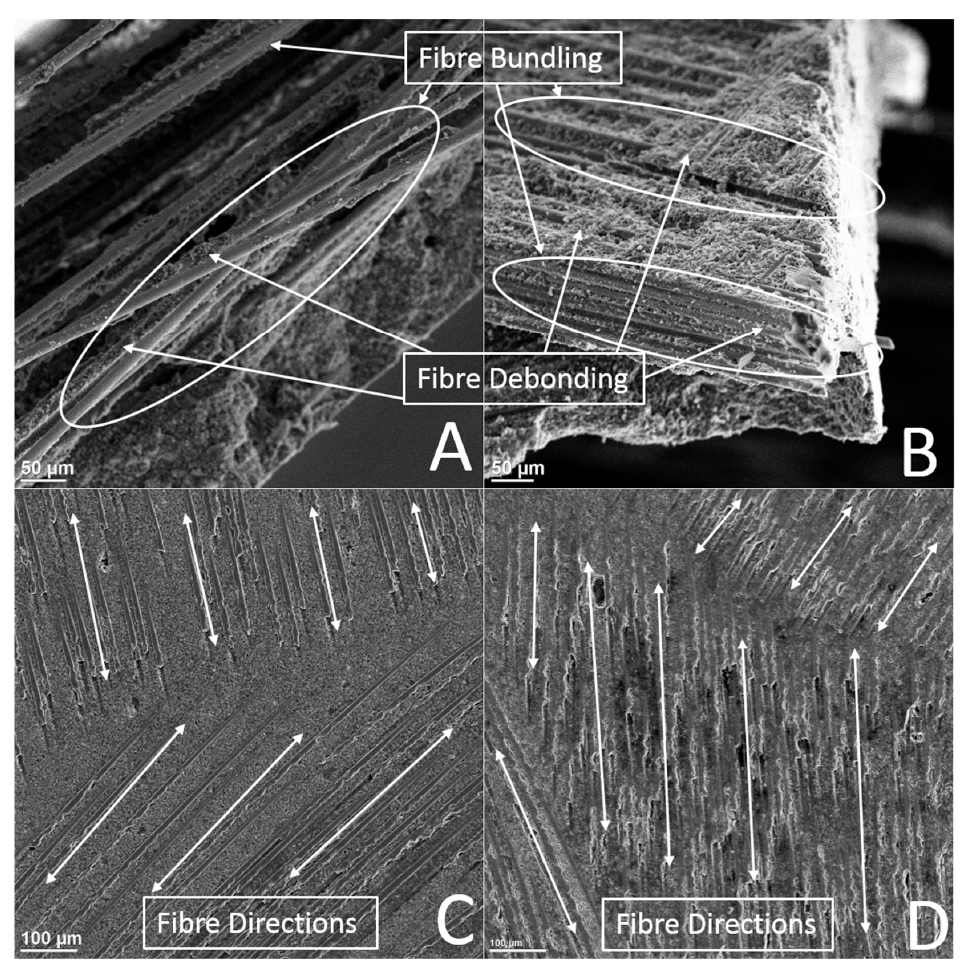
Figure 7. SEM of Tensile ( A ) Fractography 25% volume fraction (VF) at 50 μ m; ( B ) Fractography 45% VF at 50 μ m; ( C ) Top Cross-Section 25% VF 100 μ m; ( D ) Top Cross-Section 45% VF 100 μ m.